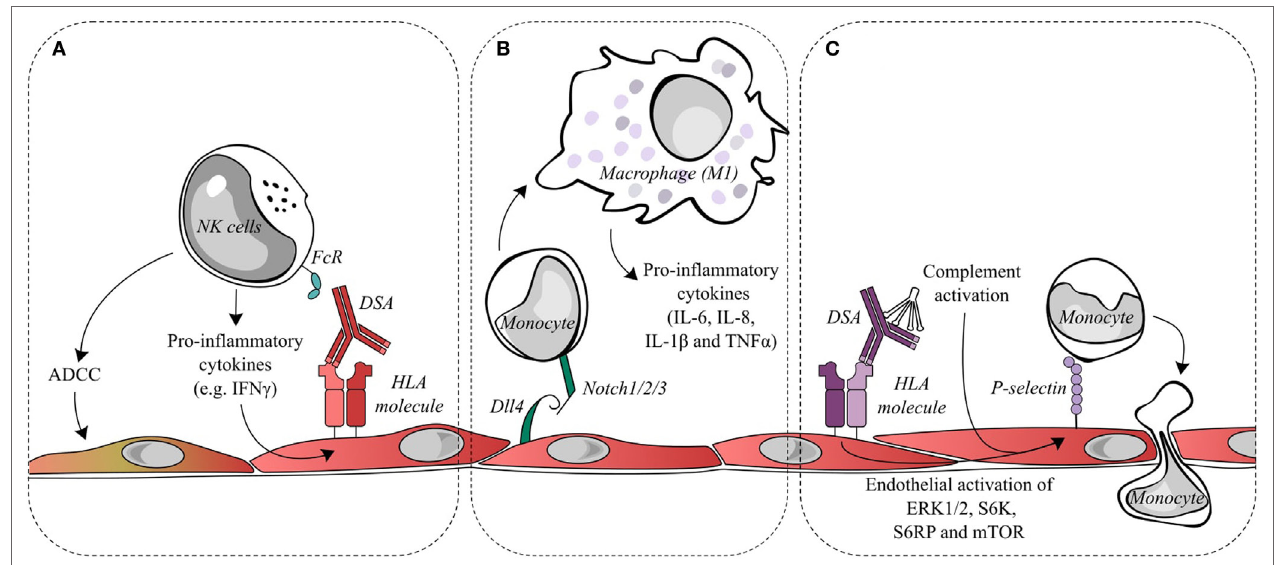
FiGURe 2 | Endothelial cell activation and recruitment of natural killer (NK) cells and monocytes. (A) Donor-specific antibodies (DSAs) binding to endothelial cells may lead to the ligation of Fc receptors on NK cells and contribute to antibody-dependent cell-mediated cytotoxicity (ADCC) directed against the allograft or to the release of pro-inflammatory cytokines, such as interferon gamma (IFN γ ). IFN γ is a key factor in the quantitative expression of HLA class II molecules. Changes in IFN γ could conceivably increase the targets for DSA and thus increase antibody-mediated damage. (B) During antibody-mediated rejection, Dll4 is upregulated on endothelial cells and is capable of modulating the differentiation of monocytes into macrophages displaying a pro-inflammatory M1 phenotype. (C) DSA binding to endothelial HLA class I molecules initiates intracellular signaling, such as the activation of ERK1/2, S6 kinase, S6 ribosomal protein, and mTOR. This signal transduction leads to the exocytosis of Weibel–Palade bodies and increases cell surface P-selection, which can augment monocyte recruitment and adhesion to the endothelial layer. Classical complement activation, resulting from DSA binding, is capable of synergizing with DSA signaling to further upregulate endothelial cell surface P-selectin and increase monocyte